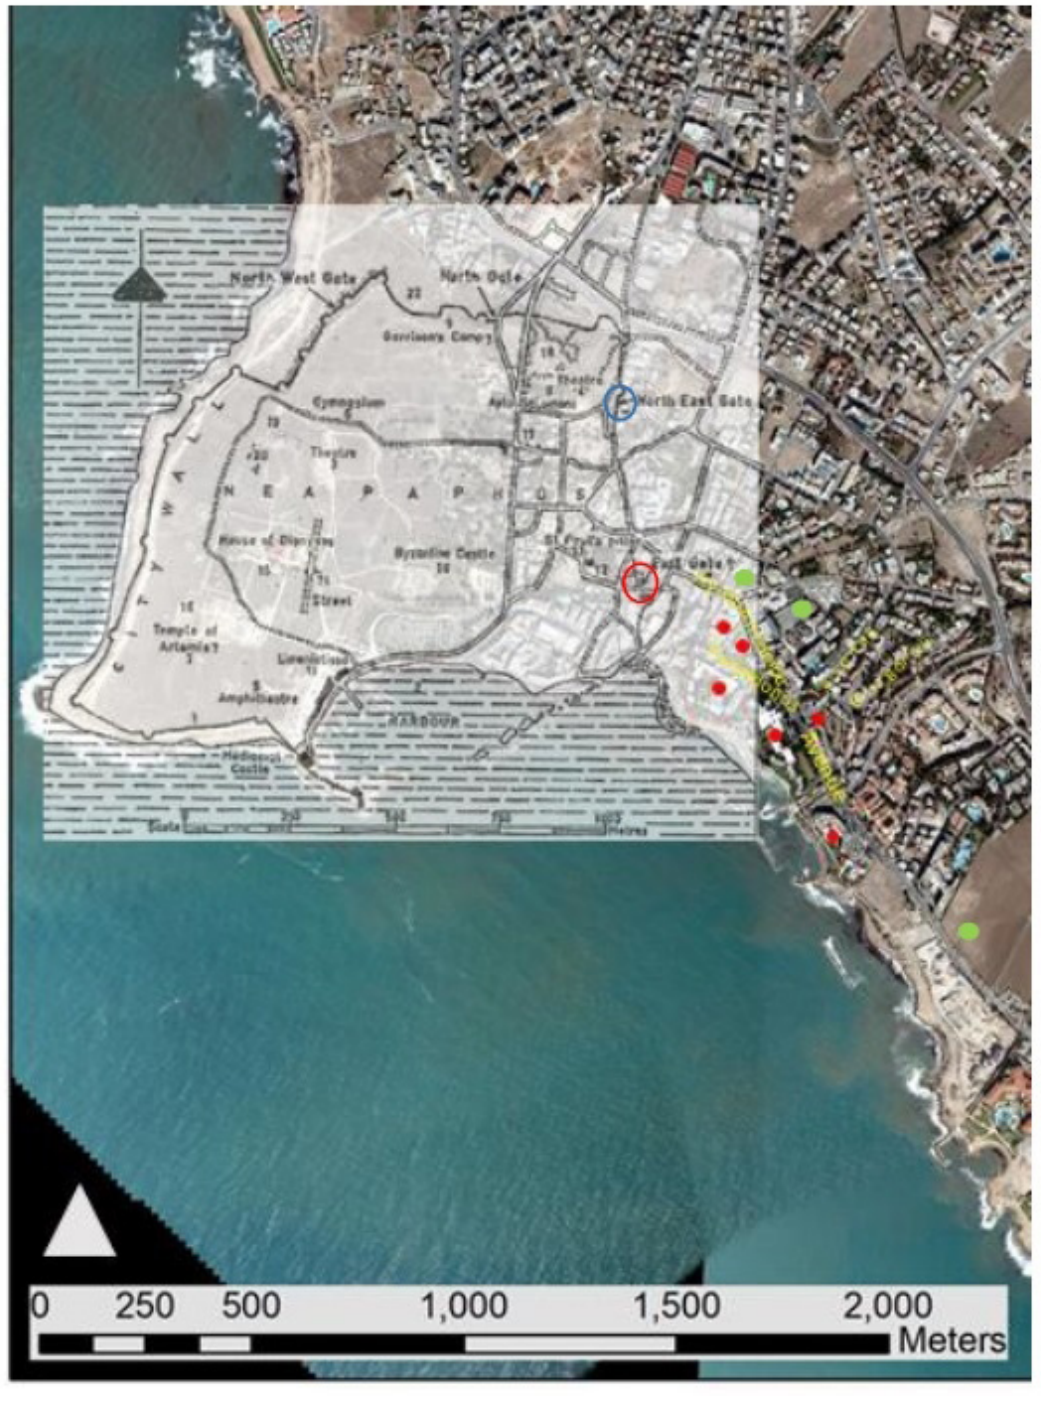
Figure 12: Visualization of the relation between the Eastern necropolis enlarged in the bottom figure (imagery source: ©Google Earth Engine, imagery date: 8/2/2017) and the ancient city of Nea Paphos (map after Nicolaou, 1966). Within red and blue circles are shown the East and North East gates, respectively. The names of the streets leading outside the city walls are given in yellow colour. Red dots indicate the investigated areas of the necropolis, with considerable number of tombs (including tombs both georeferenced and not). Green dots indi- cate new areas where archaeological proxies were spotted during the aerial investigation (beyond the already known concentrations which were also seen on the aerial